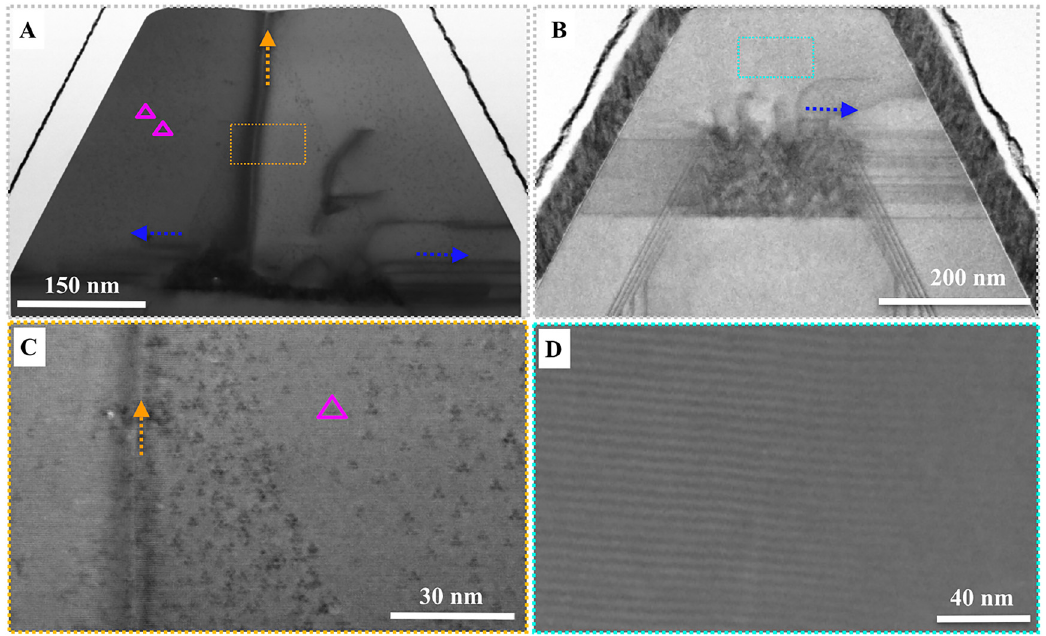
Figure 7: STEM images of the MQS and p -GaN shell at the c -plane apex region of NWs in reference and sample d.STEM images of the NW c -planeregion grown bythe (A) classical p -GaN growthmethod(ref) andwith (B)highgrowth rate of p -GaN(sample d). High magni fi cation STEM images of the p -GaN above c -plane MQS regionsfor the (C) referenceand (D)sample d, respectively. The capturedregionsare indicated by dashed